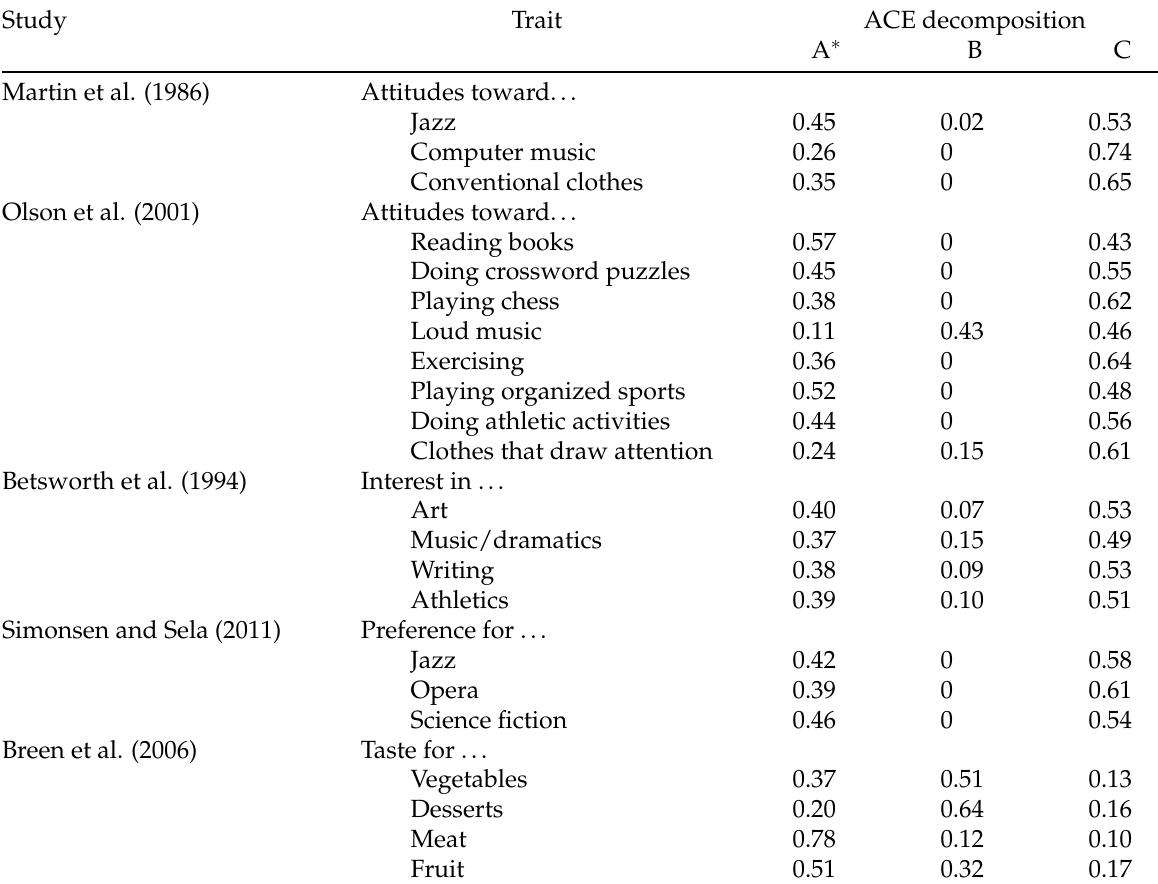
Table 1: Summary of ACE decompositions from existing research Study